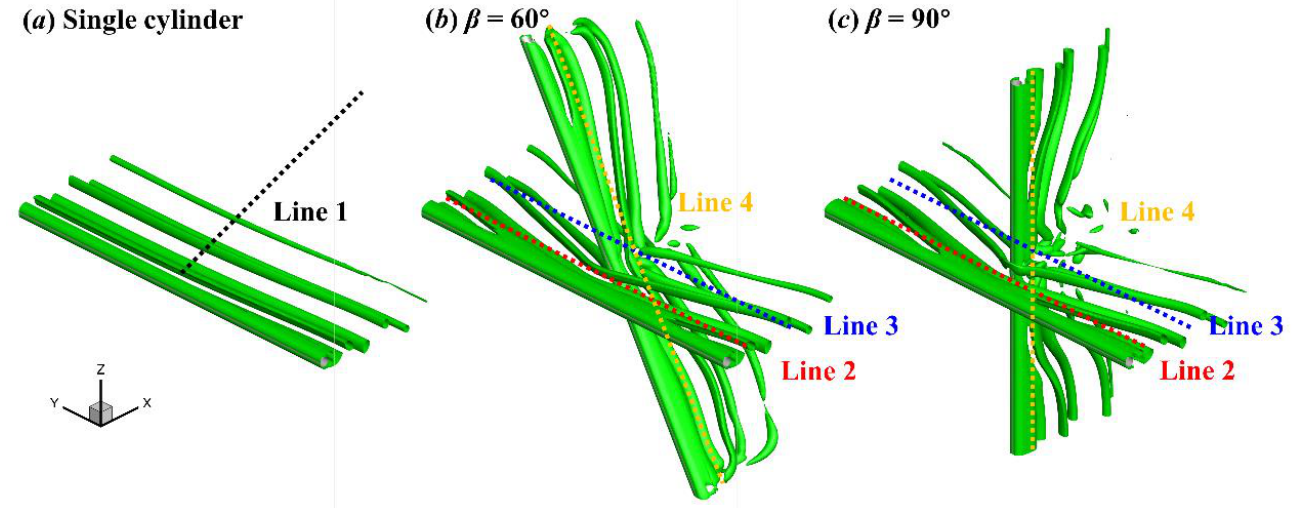
Figure 6. Instantaneous flow around the single cylinder ( a ) and two-crossing cylinders in 60° ( b ) and 90° ( c ) arrangements. Iso-surfaces λ 2 = −0.2.